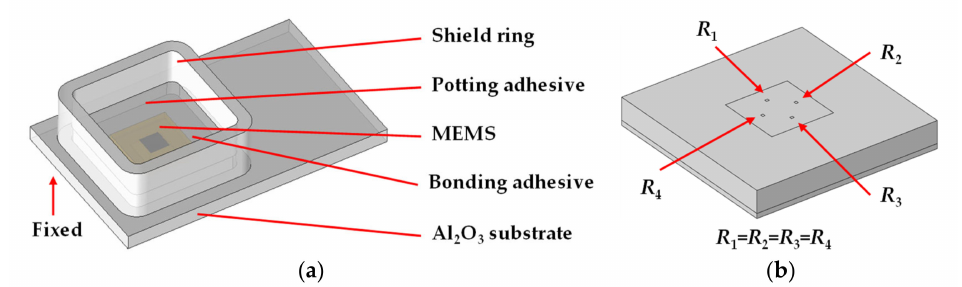
Figure 5. Geometric model of ( a ) MEMS pressure sensor; ( b ) MEMS pressure